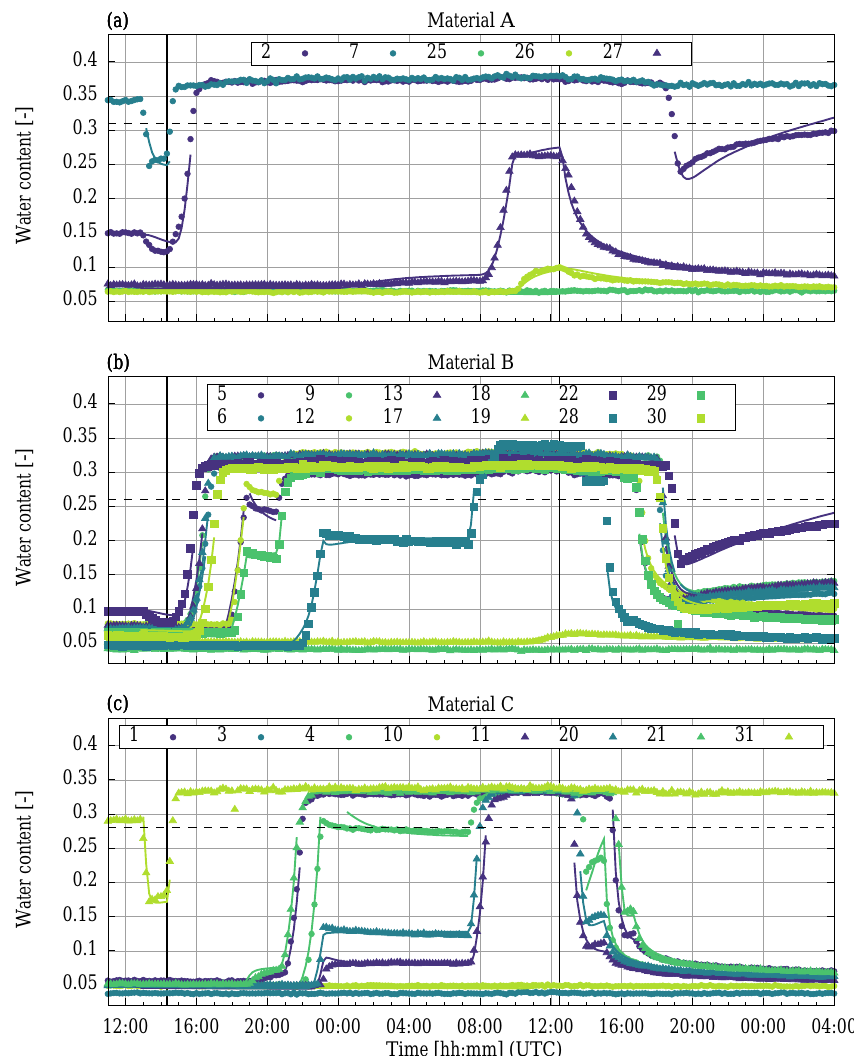
Figure 4. The measured water content data for the three different phases (initial drainage, multistep imbibition, and multistep drainage – separated by the solid vertical black lines in the figure) show a high variability up to and beyond the validity limits of the Richards equation due to the fluctuating groundwater table (Fig. 3). Hence, in order to avoid effects related to entrapped air and two-phase flow phenomena, we neglect all data with a volumetric air content smaller than 0 . 1 (all values above the dashed horizontal lines) based on measured porosities from core samples. The colored solid lines show the results of the Miller and position setup of the 2-D study (Sect. 3.2). The data measured before 12:50UTC are only used for the initial state estimation (Sect.